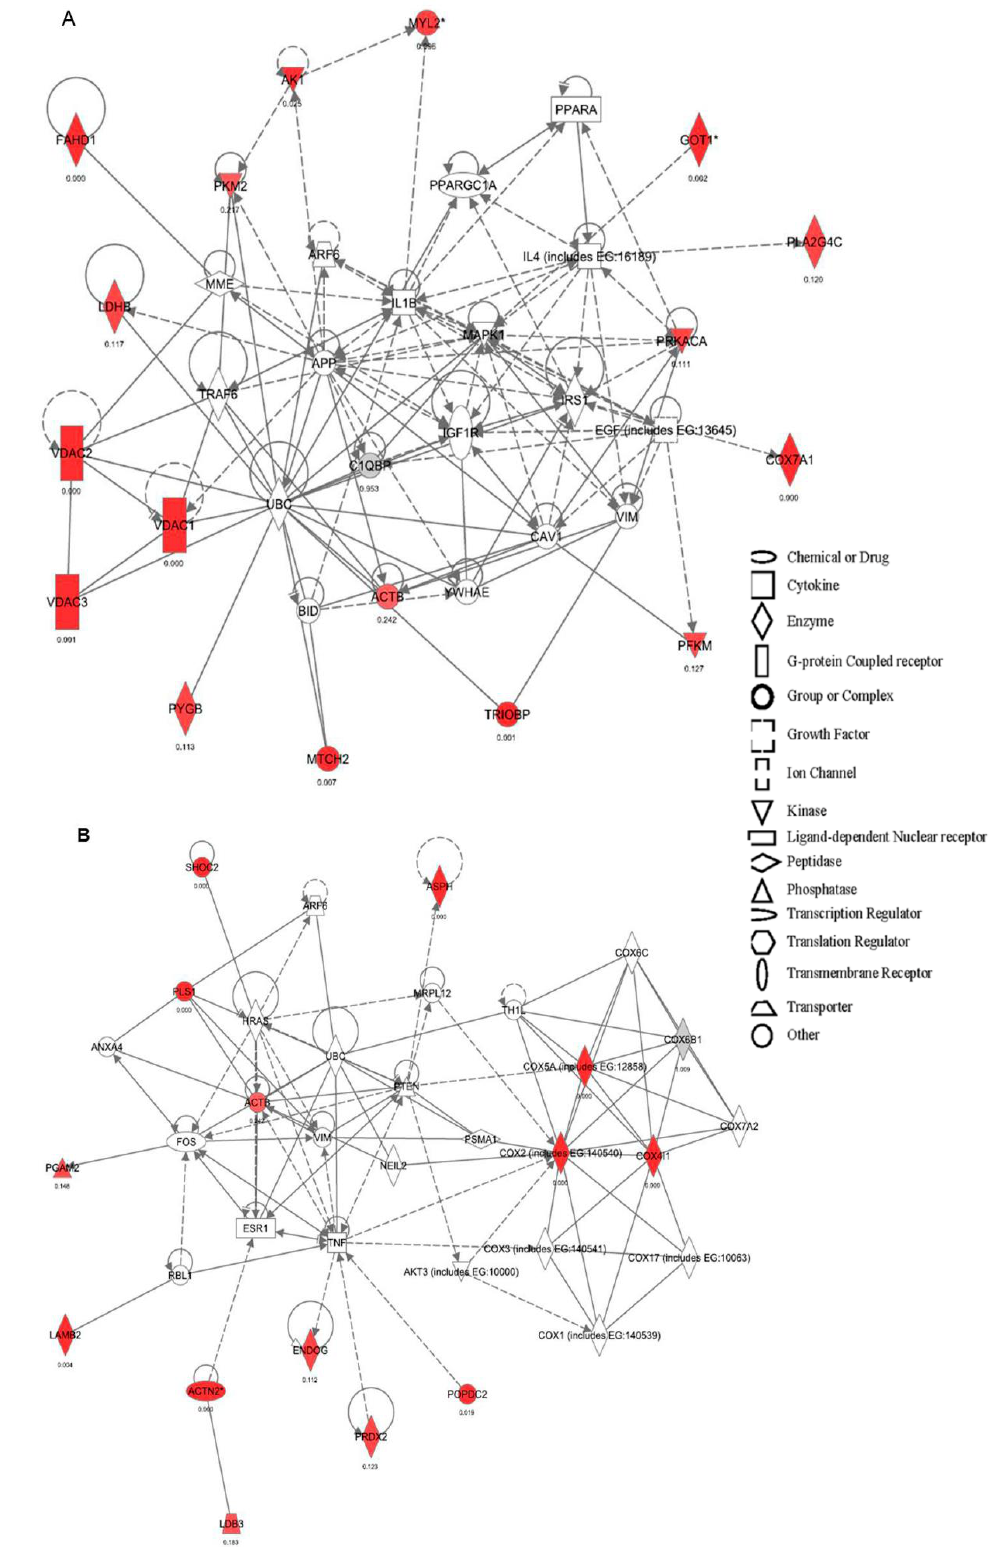
Figure 4. Networks associated with cardiac human COX-2 constitutive expression identified by ingenuity pathway analysis. Red symbols indicate upregulation, whereas green symbols